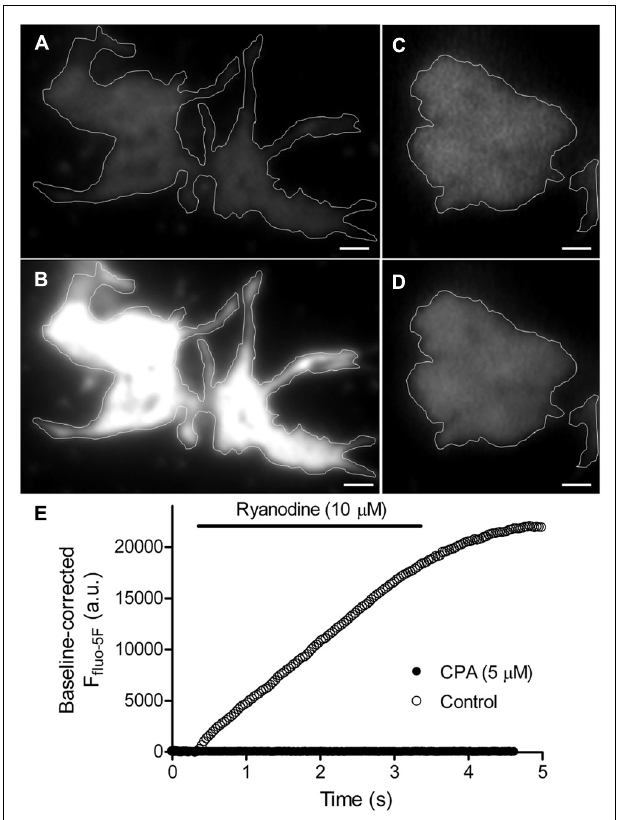
FIGURE 2 | Ca 2 + -induced Ca 2 + release (CICR) occurs near plasma membrane in rod terminals. Panels (A,C) show average images of the footprints of two rod terminals loaded with fluo-5F (averaged from 19 frames and 9 frames, respectively; 31 ms/frame). Rods were stimulated by puff application of the ryanodine receptor agonist, 10 μ M ryanodine, for 3 s. In control conditions, activation of CICR with ryanodine stimulated large increase in submembrane Ca 2 + throughout the terminal ( B ; average of 33 images). After inhibiting the sarcoplasmic/endoplasmic reticulum ATPase (SERCA) by bath application of 5 μ M cyclopiazonic acid (CPA), ryanodine puff failed to stimulate a Ca 2 + increase ( D ; average of 29 frames).The changes in fluo-5F fluorescence intensity measured within these two terminals are plotted in (E) . Scale bar: 1 μ m.